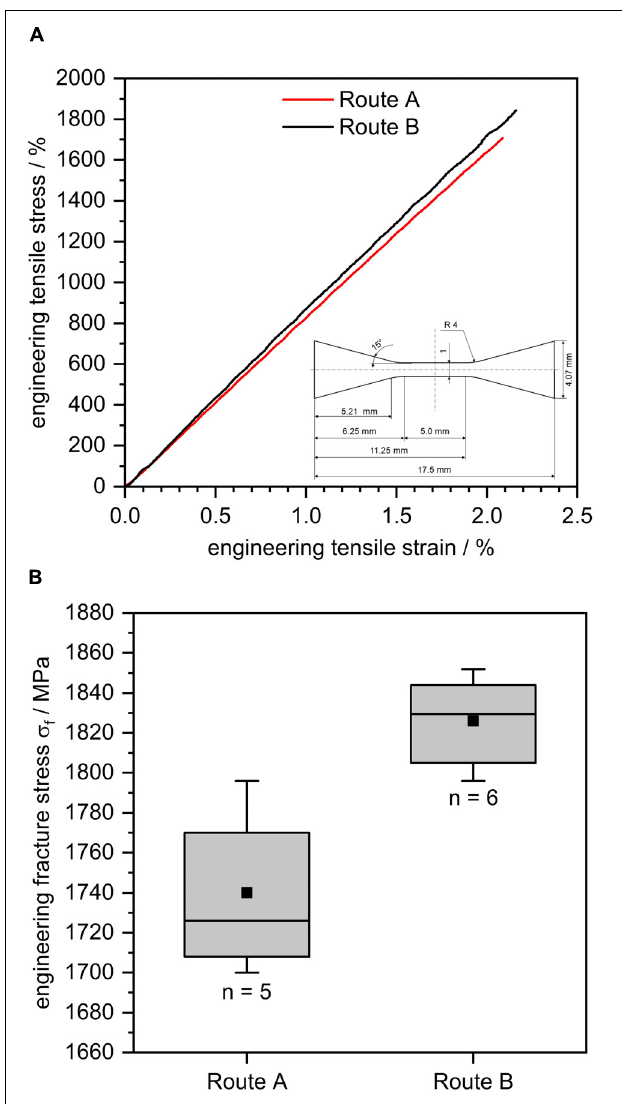
FIGURE 7 | Scanning electron microscopy (SEM) fracture surface images of the samples corresponding to the stress strain curves depicted in Figure 6A : (A) fracture surface of sample type A, (B) fracture surface of sample type